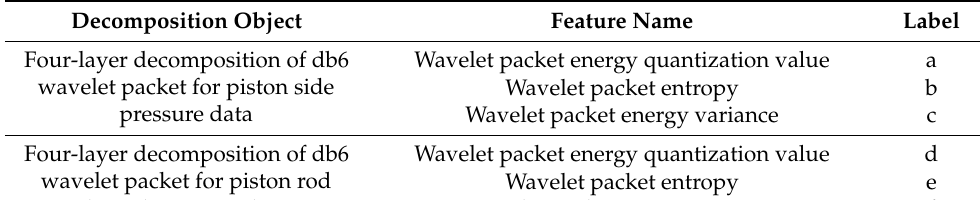
Table 6. Fault characteristics of wavelet packets.